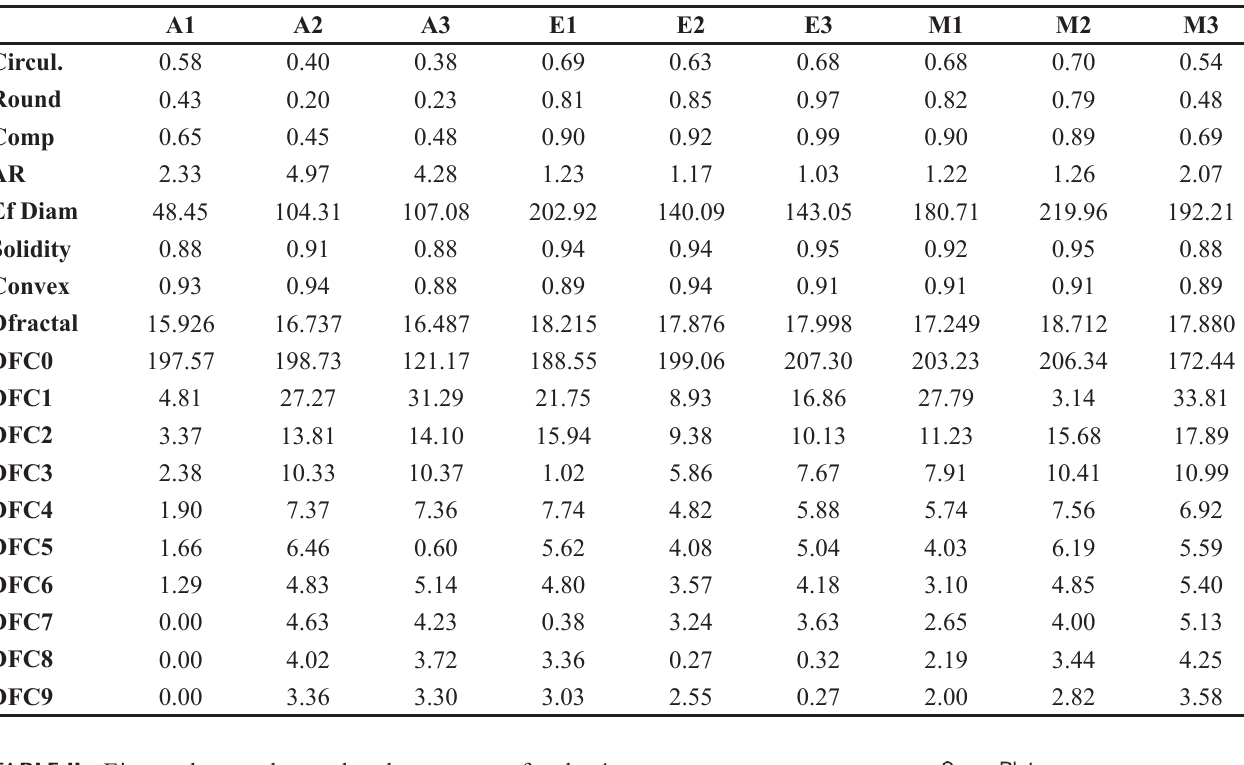
TABLE II - Eigenvalues and cumulated percentage for the 4